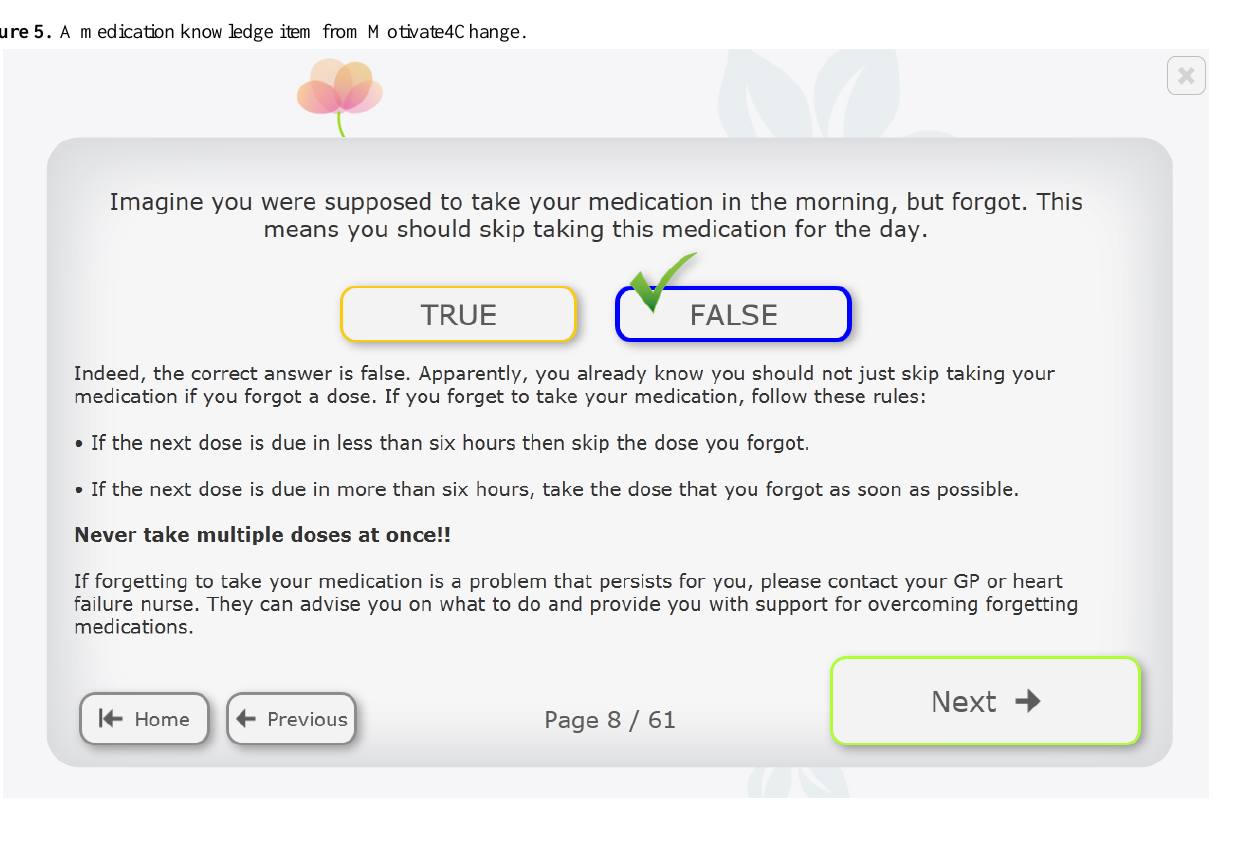
Figure 5. A medication knowledge item from